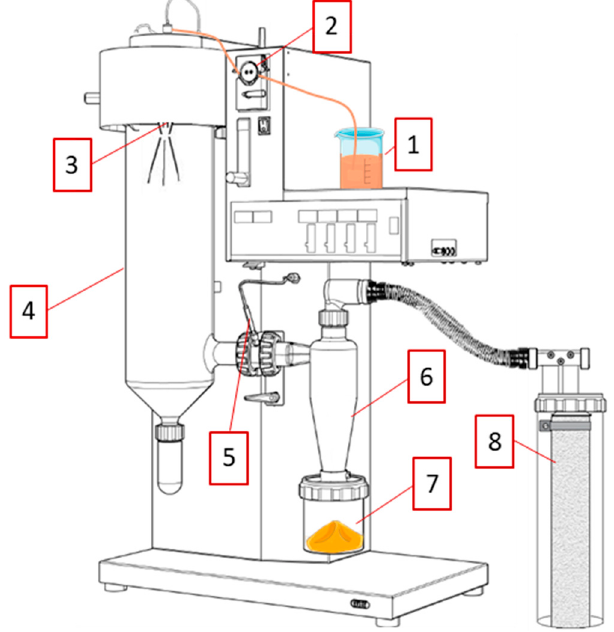
Figure 1. Scheme of spray dryer used for microencapsulation experiments. (1) Liquid feed; (2) peristaltic pump; (3) two-fluid nozzle; (4) drying vessel; (5) thermocouple for outlet temperature detection; (6) cyclone; (7) collection vessel; (8) filter. Adapted from BÜCHI mini spray dryer B-290 operation manual.